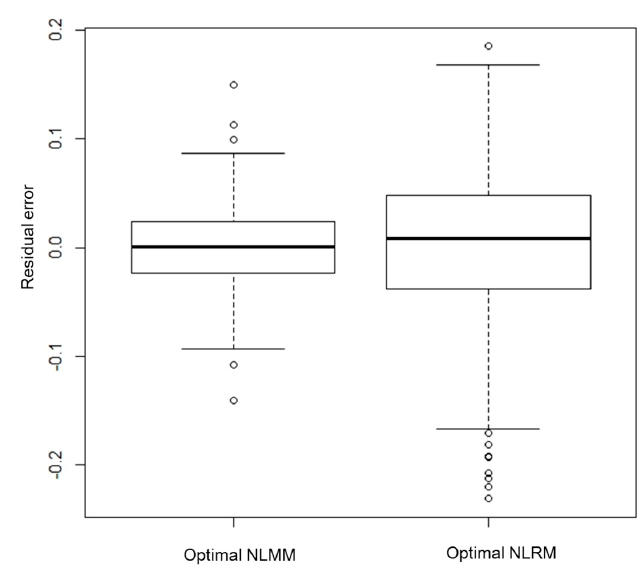
Figure 4. Parallel boxplots of residual errors in the non-linear mixed model (NLMM) and ordinary non-linear regression model (NLRM) .